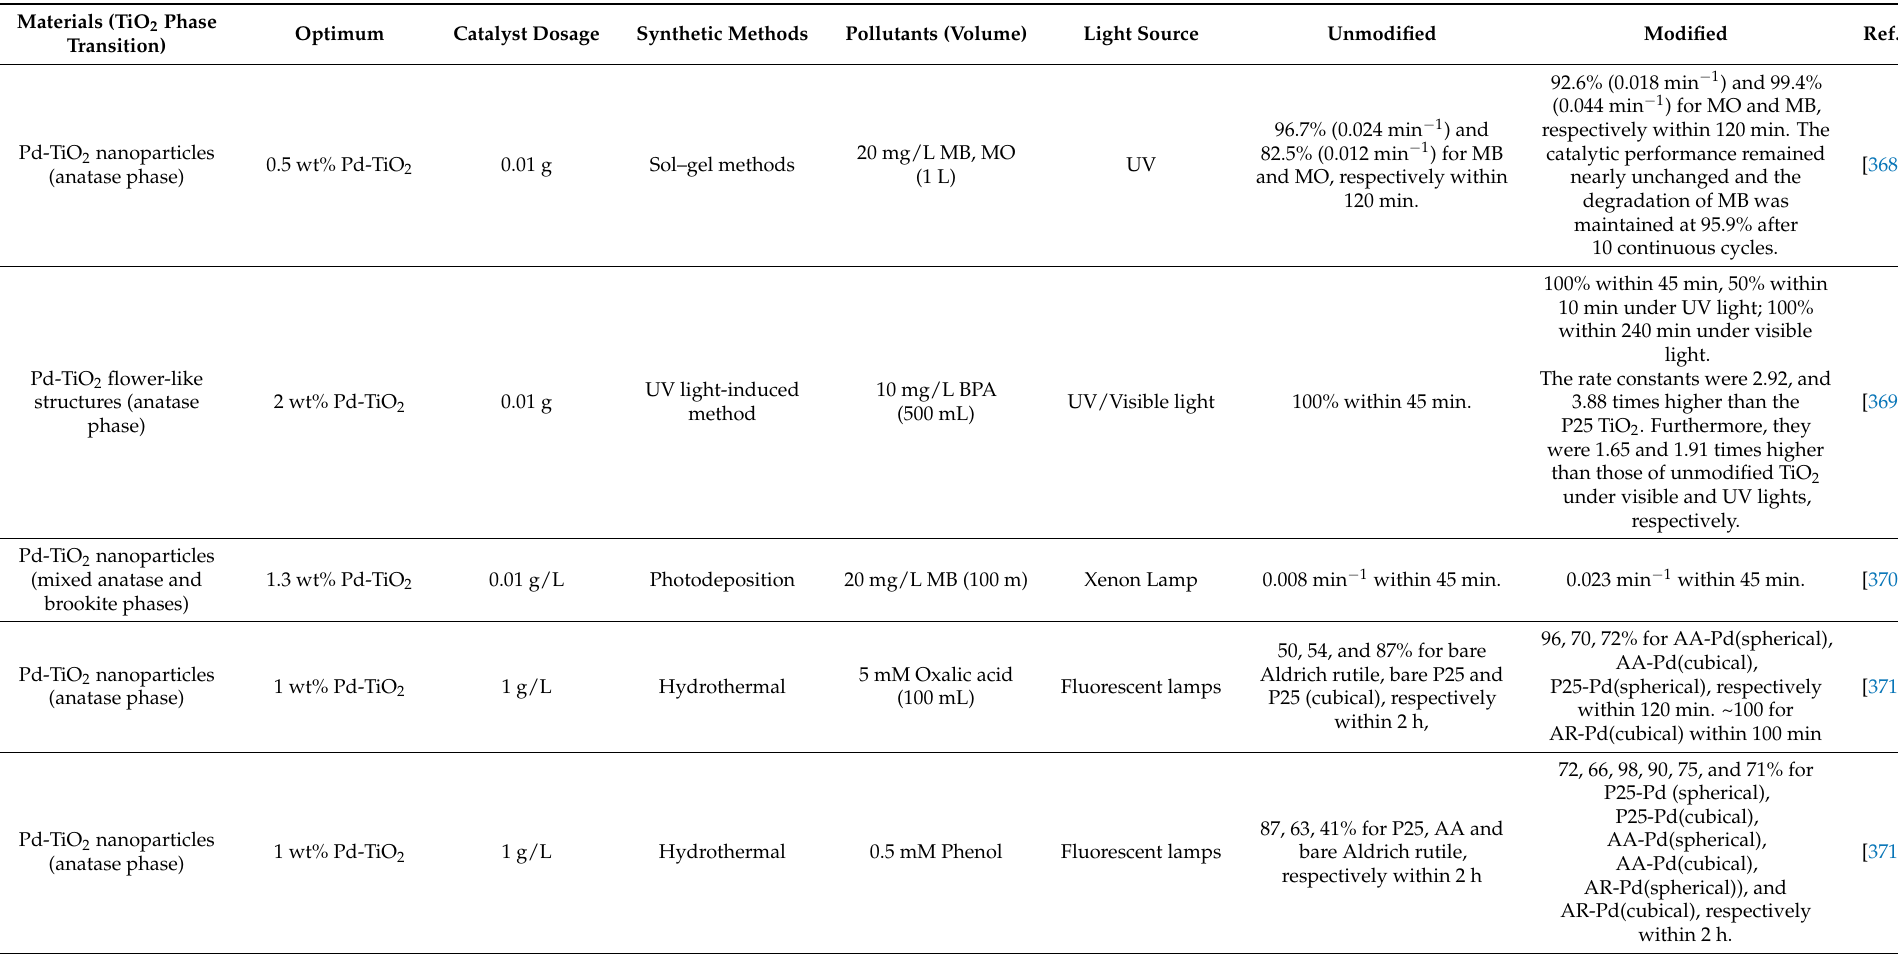
Table 19. Summary of recent progress on Pd-TiO 2 photocatalysts for organic pollutants